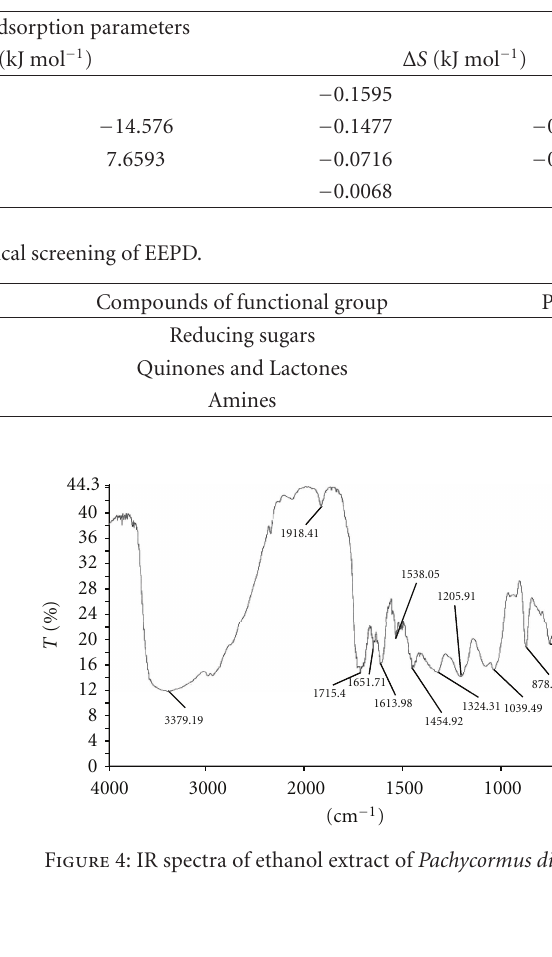
Table 6: Thermodynamic adsorption parameters for EEPD on carbon steel 1018 in 1M HCl at di ff erent temperatures.